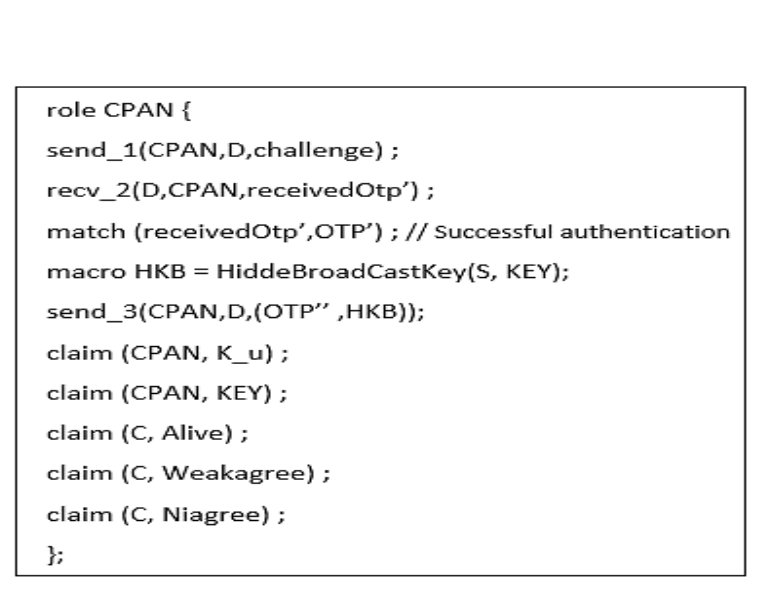
Figure 5. Role of CPAN